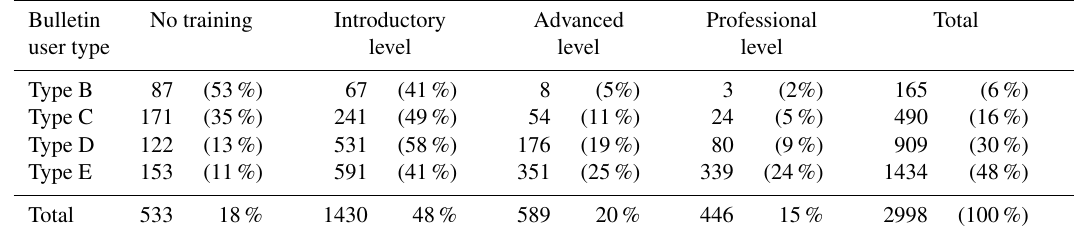
Table 1. Distribution of avalanche training levels with respect to self-identified bulletin user type within the final dataset. Percentage values are row percentages except in the total column where they represent column